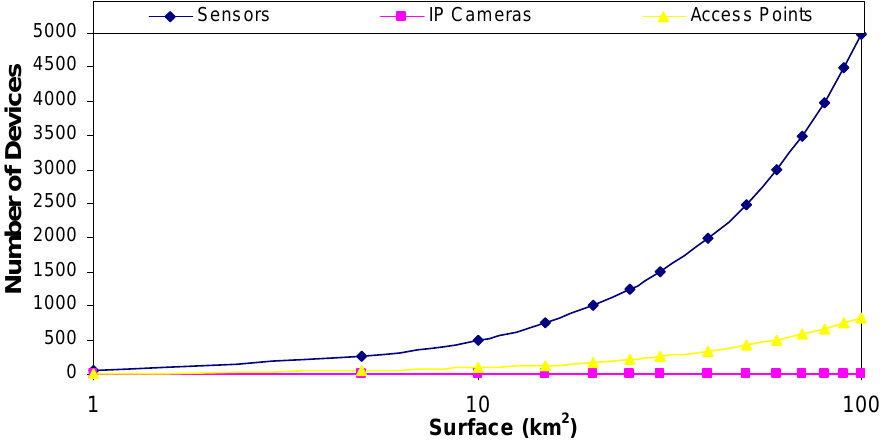
Figure 4. Number of devices needed per area that is wanted to be covered.